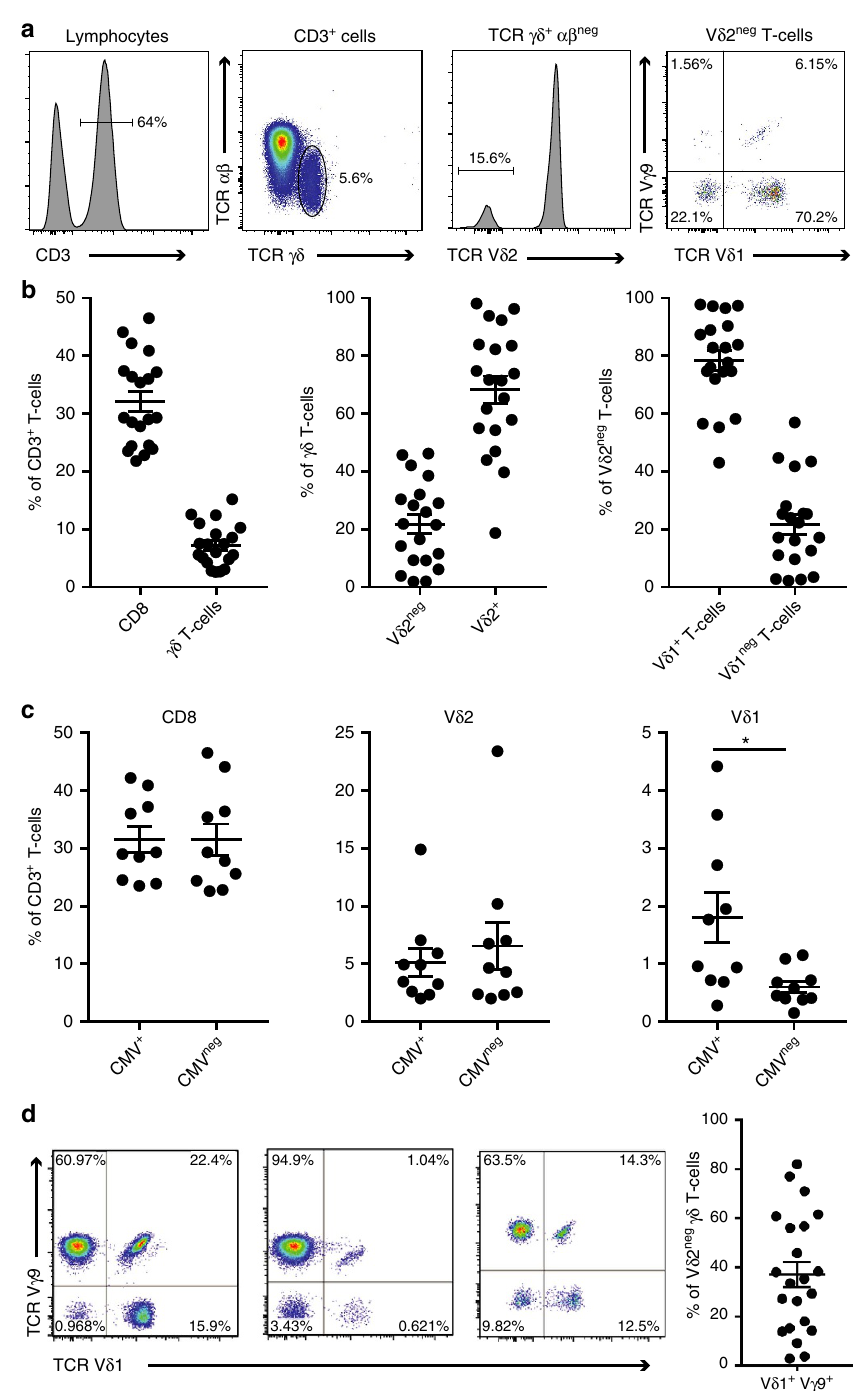
Figure 1 | Peripheral blood cd T-cell populations in donors analysed for cd TCR repertoires. ( a ) Major peripheral blood gd T-cell populations identified by gd TCR chain specific antibodies. Flow cytometry plots are representative of 20 donors. ( b ) Frequency of gd T cells in CD3 þ lymphocytes (left graph), abundance of V d 2 þ and V d 2 neg T cells in the gd T cell compartment (Middle), and proportion of V d 1 þ T cells in the V d 2 neg gd T-cell sub-population (Right). Graphs show the mean ± s.e.m. from 20 donors. ( c ) Effect of donor CMV-seropositivity on CD8 þ , V d 2 þ and V d 1 þ cell percentages in total Tcells. Graphs show the mean ± s.e.m. from 10 CMV-seropositive and 10 CMV-seronegative donors. ( d ) Prevalence of a V g 9 chain pairing in V d 1 þ Tcells. Graphs show the mean ± s.e.m. and flow cytometry plots are representative of 20 donors. Data analysed by student’s t -test, * P ¼